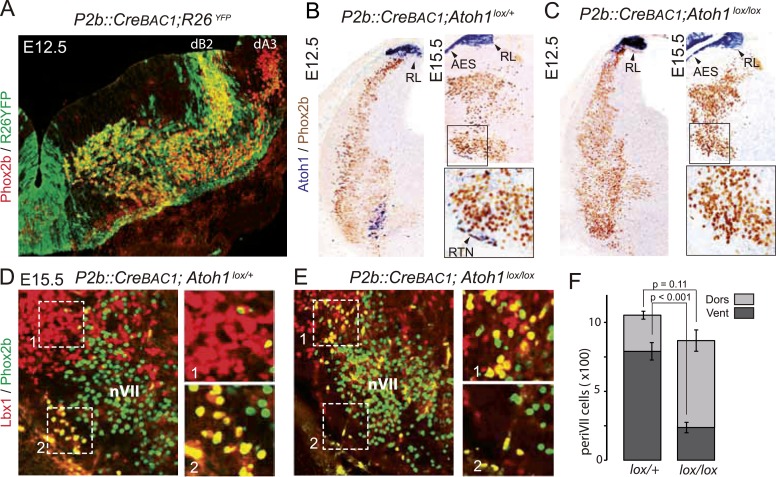
Selective removal of Atoh1 in RTN precursors produces a ventral to dorsal shift of periVII neurons.(A) Combined Phox2b (red) and YFP (green) staining on a transverse section of an E12.5 P2b::CreBAC1;R26YFP (Srinivas et al., 2001) hindbrain showing efficient recombination of the reporter allele in dB2 progenitors. In the dA3 domain, where Phox2b and Cre are switched on postmitotically, newly born cells are still YFP− but express it during their ventral migration. (B and C) Combined Atoh1 ISH with a CDS probe of Atoh1 and Phox2b IHC on coronal hindbrain sections of P2b::CreBAC1;Atoh1lox/+ (B) or P2b::CreBAC1;Atoh1lox/lox embryos (C) at E15.5 or E12.5 as indicated. Cre recombinase expressed from the Phox2b promoter removes Atoh1 message in the RTN precursors but not in the rhombic lip (RL) or the cells of the anterior extramural stream (AES) of Atoh1lox/lox embryos. Higher magnifications of the boxed areas are shown below. (D and E) Immunofluorescence for Lbx1 (red) and Phox2b (green) on coronal E15.5 hindbrain sections of the indicated genotypes (dorsal at top, lateral on the left). The double-labeled periVII cells are in yellow, the insets show close ups corresponding to the boxed areas. The Lbx1+/Phox2b+ cells accumulate dorso-laterally of nVII in P2b::CreBAC1;Atoh1lox/lox mutants. (F) Quantification of the Lbx1+/Phox2b+ periVII cells at E15.5 located ventrally (Vent) or dorsally (Dors) of nVII. In P2b::CreBAC1;Atoh1lox/+ controls, 25 ± 2.3% of the periVII neurons are located dorso-laterally of nVII vs 75 ± 2.6% in P2b::CreBac1;Atoh1lox/lox mutants.